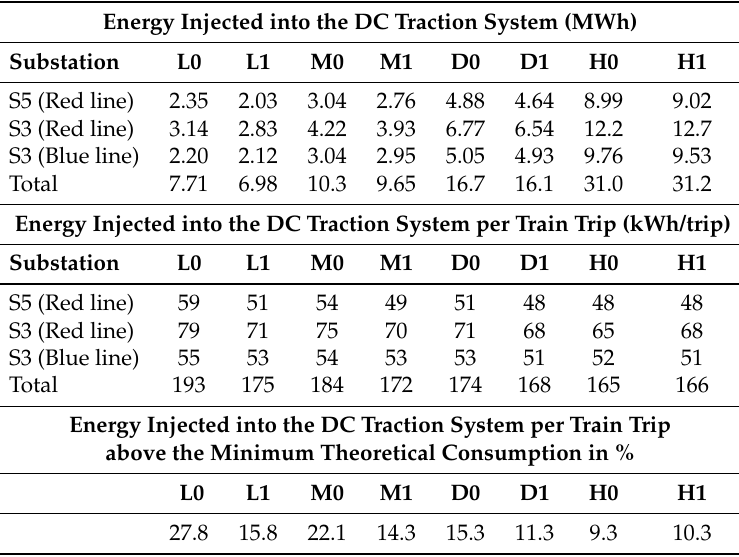
Table 7. Summary of the substations’ behavior in all